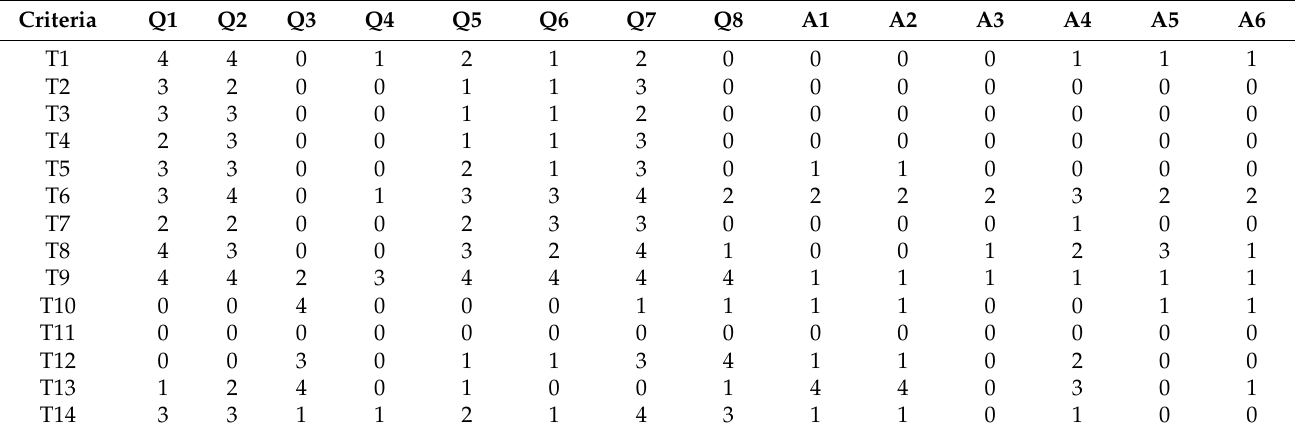
Table 1. Matrix of the direct impact of PV criteria. Own